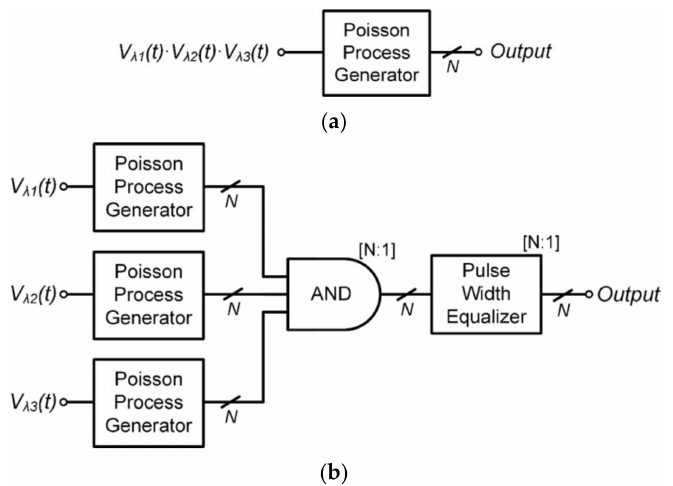
Figure 3. Block diagram of Poisson process generation in which the event rate is determined by ( a ) conventional analog multiplication and ( b ) proposed stochastic multiplication of logic AND